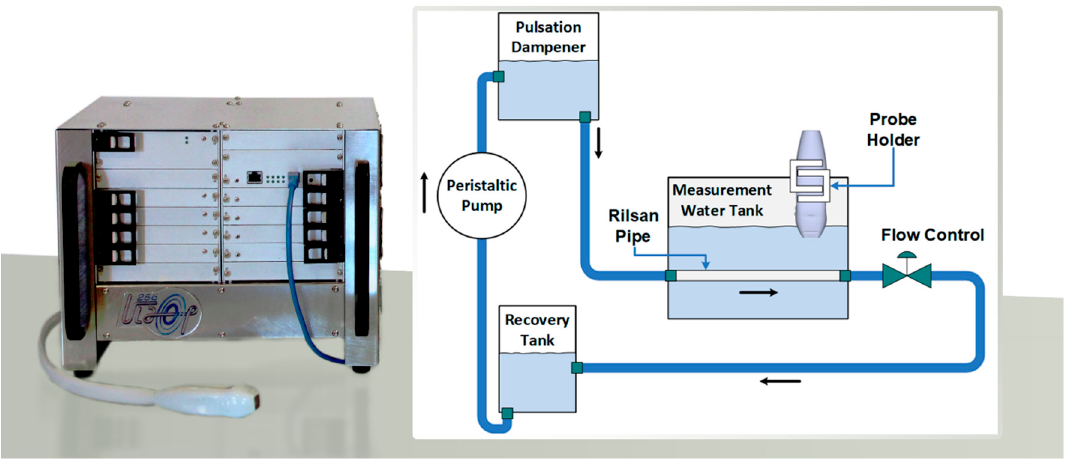
Figure 4. On the left, the ULA-OP 256 scanner with the Vermon probe used for the experiments. On the right, the schematic diagram of the flow